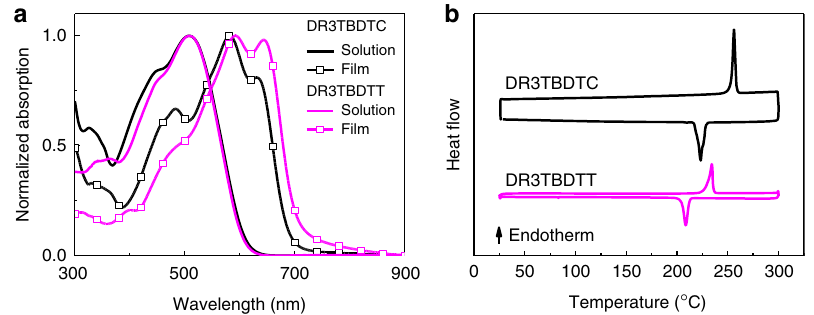
Fig. 2 UV – vis absorption and DSC thermogram of small molecule donors. a Normalized absorption spectra of DR3TBDTC and DR3TBDTT in CB solution (1 × 10 − 5 M) and in thin fi lm (spin-coated from CB solution). b DSC second heating and cooling cycles of DR3TBDTC and DR3TBDTT in